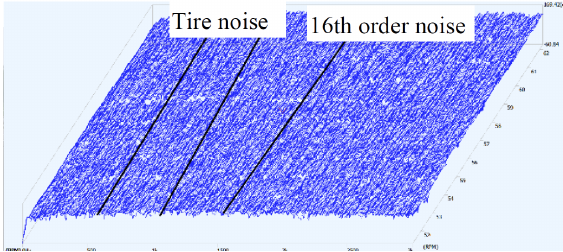
Fig. 2. Noise waterfall array analysis on the left side of Road (Acceleration condition).